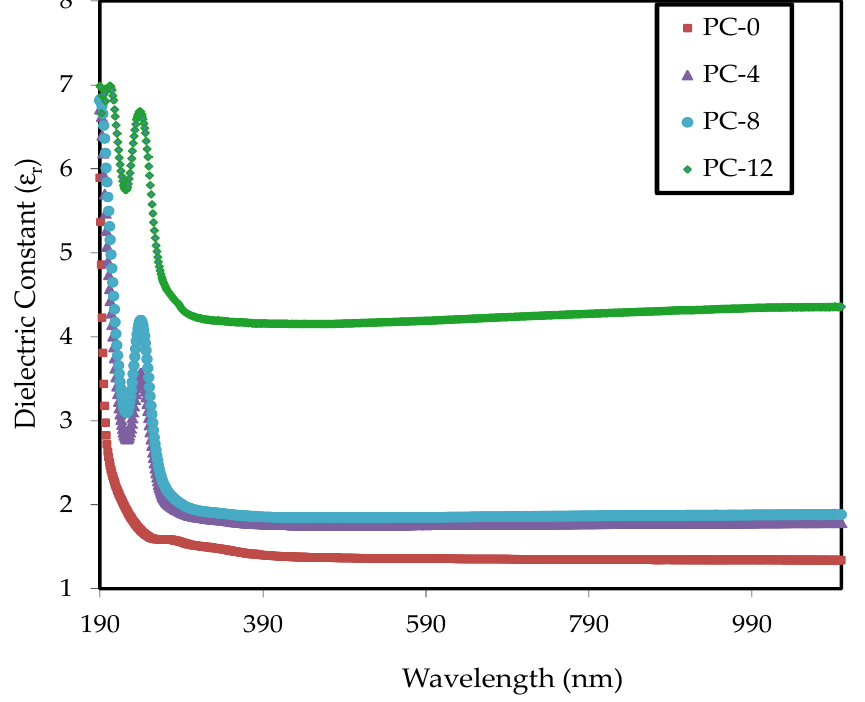
Figure 10. ε r for PVA and PVA-loaded samples.